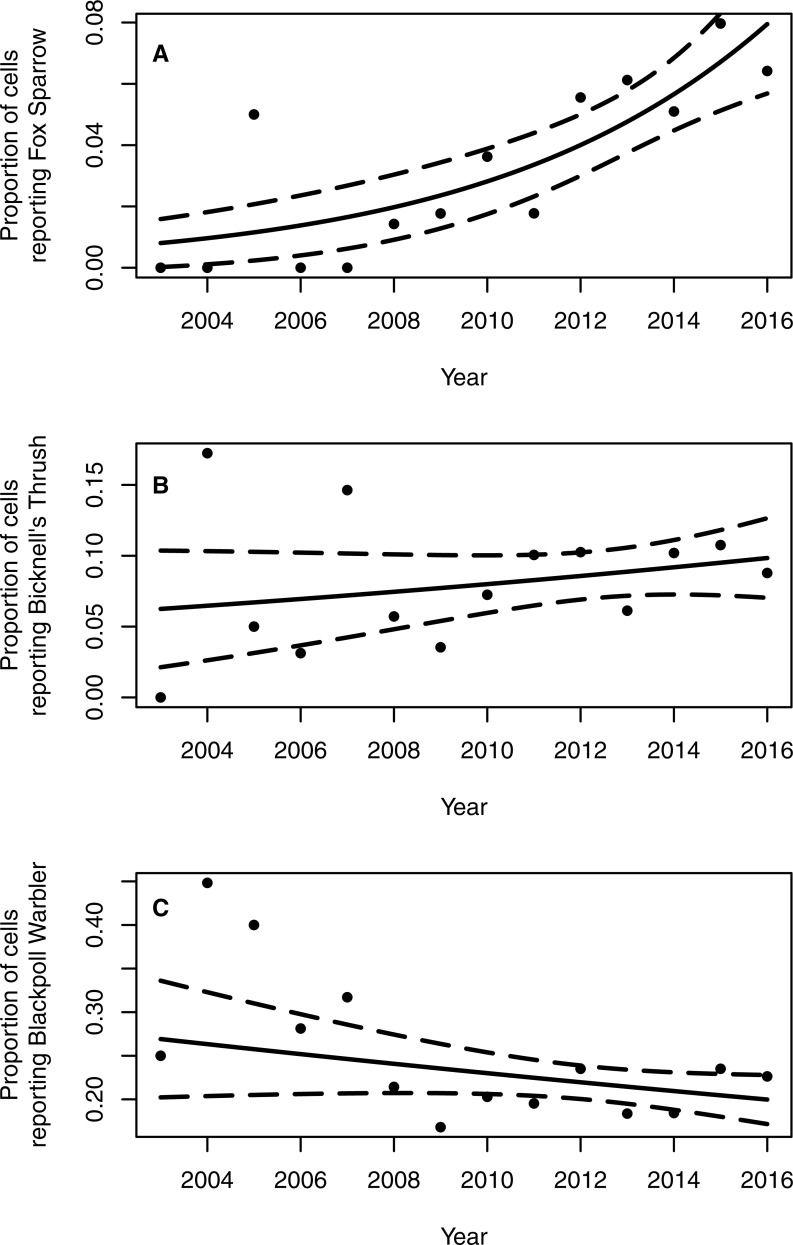
Proportion of 10 km2 grid cells in northern and western Maine and northern New Hampshire containing eBird checklists with observations of Fox Sparrow, Bicknell’s Thrush, and Blackpoll Warbler.The proportion of 10 km2 grid cells in northern and western Maine and northern New Hampshire containing breeding season records of Fox Sparrows reported to eBird increased 18% per year from 2003–2016 (A). Neither Bicknell’s Thrush (B) nor Blackpoll Warbler (C), both of which occur in similar forest types as Fox Sparrow, showed a significant temporal trend in the proportion of grid cells reported as occupied. Solid lines show the estimated trend in frequency of grid cells with a record of the species and dotted lines indicate the 95% confidence interval around the estimated trend.